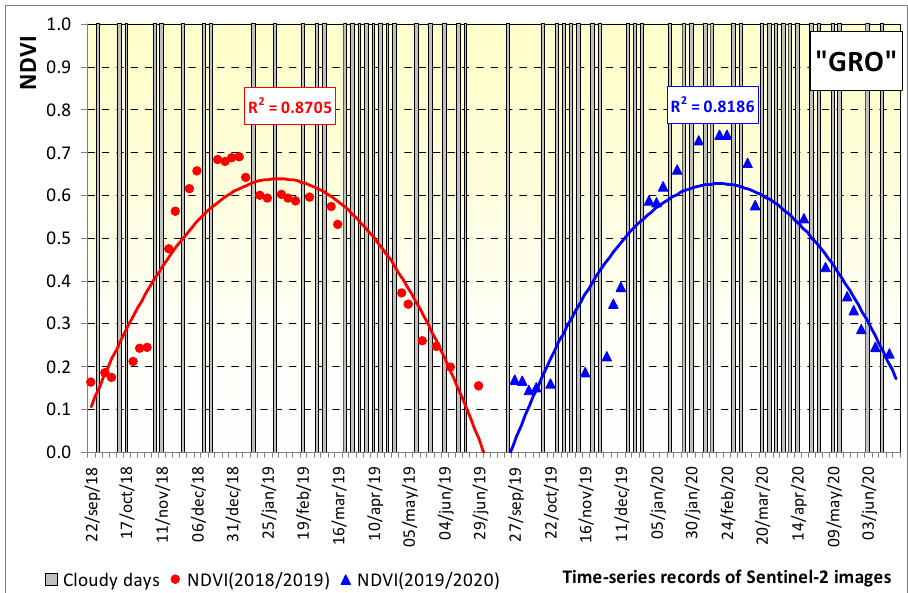
Figure 10. NDVI time-series records obtained in 2018/2019 and 2019/2020 in “GRO” field.